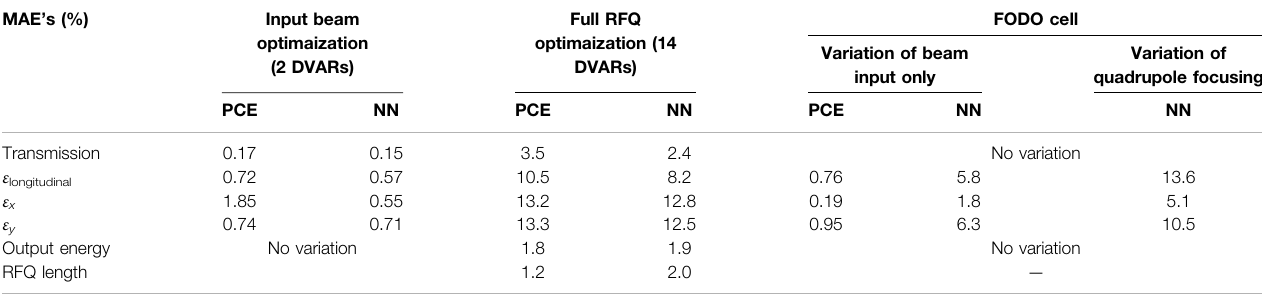
TABLE 6 | Comparison between mean average errors (MAEs) for surrogate models based on polynomial chaos expansion (PCE) and neural networks (NN) for different optimization cases and objectives. MAE ’ s (%) Input beam